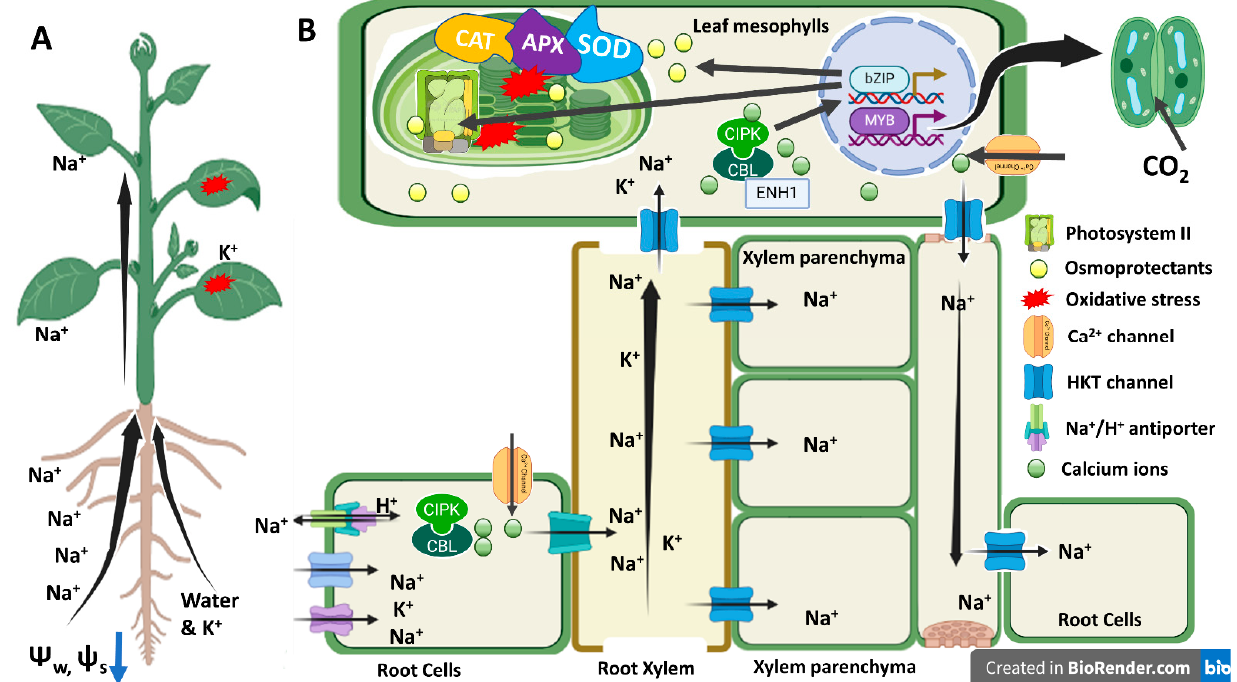
Figure 9. Physiological and molecular mechanism of salt tolerance in canola. ( A ) Salt stress increases Na + uptake and translocation from root to shoot, while it reduces water and K + uptake. This causes nutritional imbalance and oxidative stress. ( B ) Na + uptake at the root level occurs via potassium channels. Xylem parenchyma unloads Na + from xylem via HKT channel. Plant cells sense Na + via Ca 2+ channels which activate downstream hormonal signaling pathways, photosynthesis, and antioxidant potential.